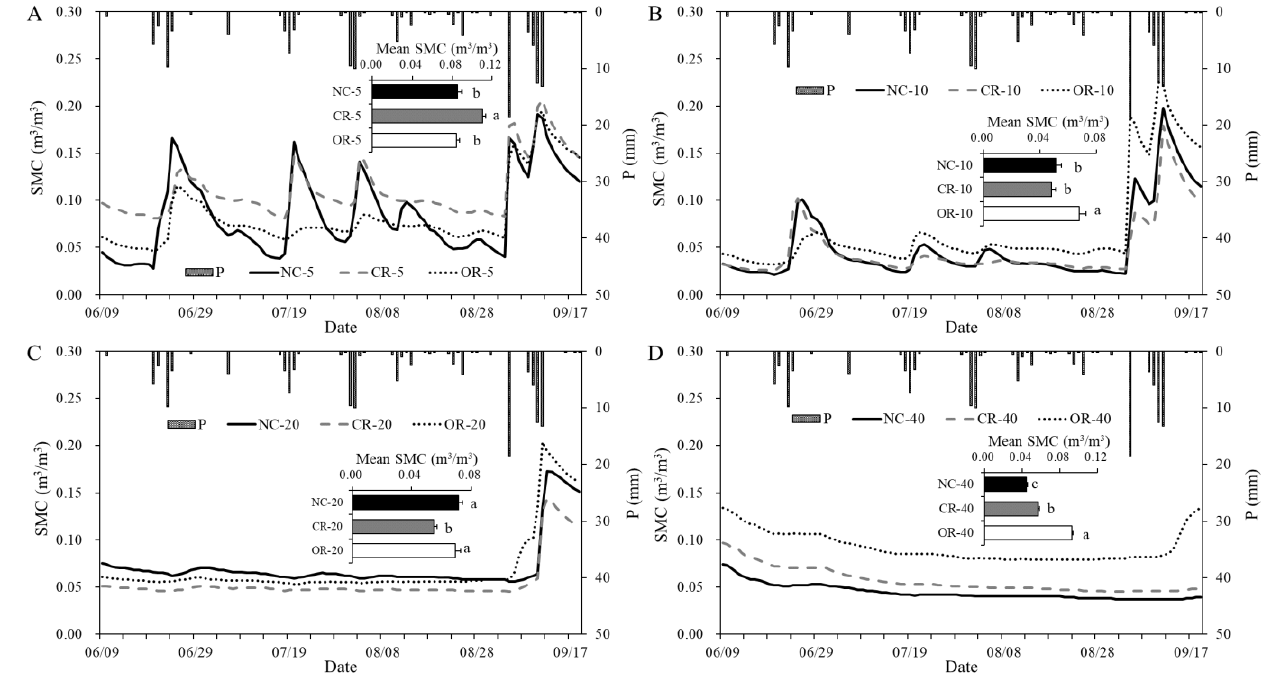
Figure 3. Dynamics of the daily SMC and its mean value at different depths for different treatments. ( A – D ) describe depths of 5 cm, 10 cm, 20 cm, and 40 cm, respectively. Different letters show a significant difference at p < 0.05. P: precipitation, NC: natural condition, CR: canopy + roots, OR: only roots.